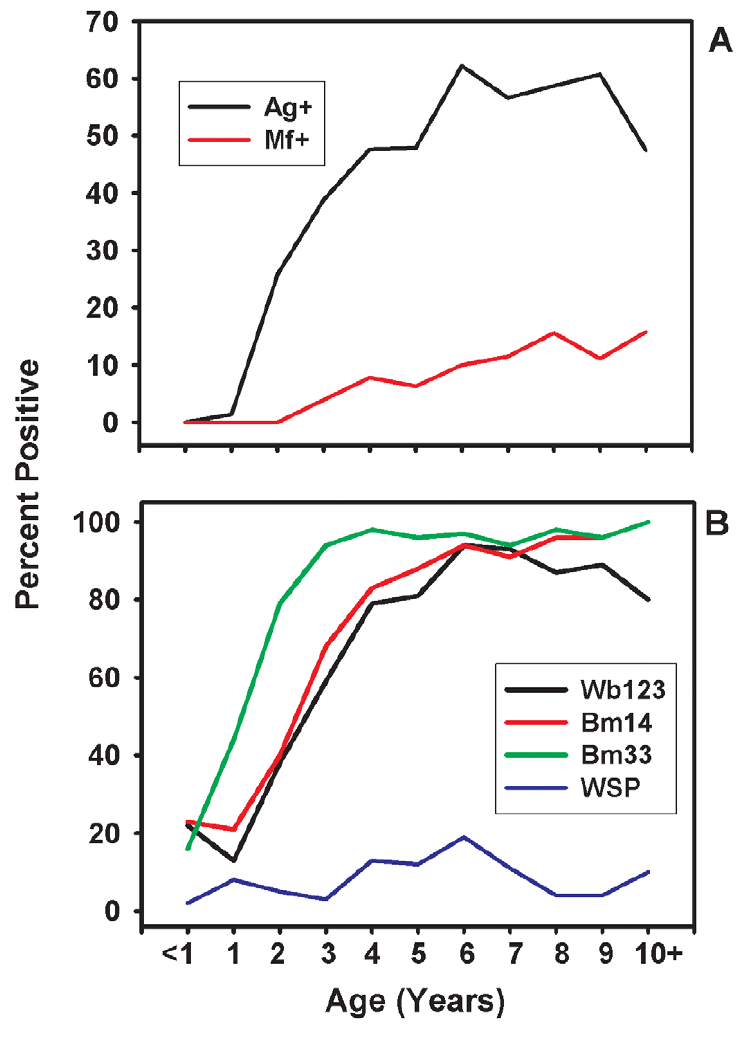
Figure 3. Age prevalence of microfilaremia, antigenemia and antifilarial antibody responses. Circulating filarial antigen and microfilaria prevalence are shown in the top panel A. Antibody responses to Bm14, Bm33, Wb123, and WSP filarial antigens are shown in the bottom panel